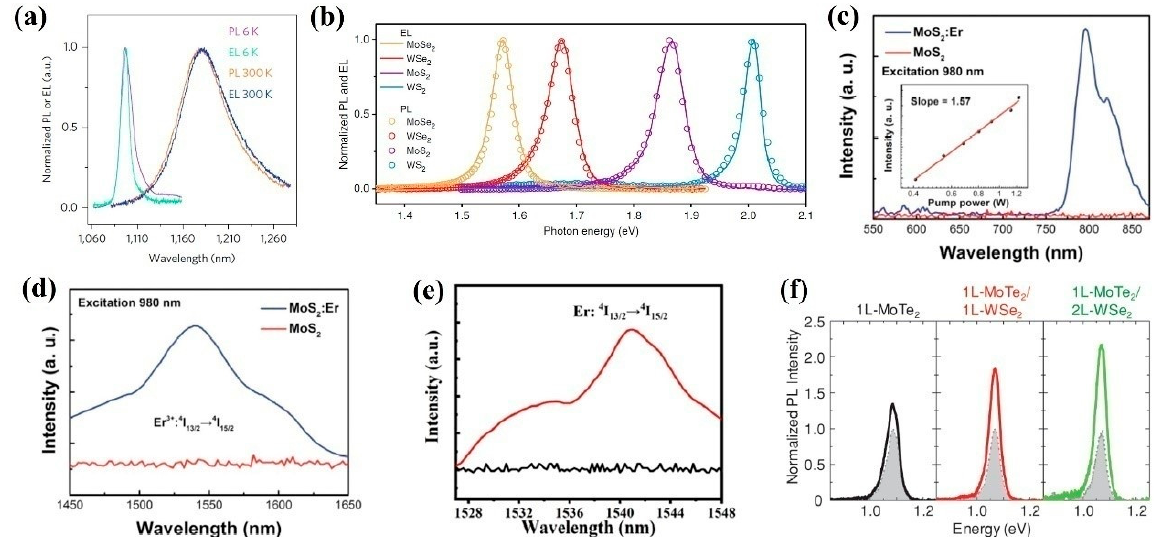
Figure 3. TMDC-based light emission and devices. ( a ) The PL and EL spectra of bilayer MoTe 2 . ( b ) The PL and EL spectra of monolayer MoSe 2 , WSe 2 , MoS 2 , and WS 2 . ( c , d ) The UC and DC PL spectra of MoS 2 , respectively. ( e ) The DC PL spectra of WSe 2 with and without Er − doped treatment. ( f ) The PL spectra of 1L − MoTe 2 , 1L − MoTe 2 /1LWSe 2 , and L − MoTe 2 /2L − WSe 2 . ( a ) Reprinted from [138], with permission from Springer Nature, 2017; ( b ) Reprinted from [139], with permission from Springer Nature, 2018; ( c , d ) Reprinted from [140], with permission from Wiley-VCH, 2016; ( e ) Reprinted from [141], with permission from Elsevier, 2021; ( f ) Reprinted from [142], with permission from Wiley- VCH, 2018.